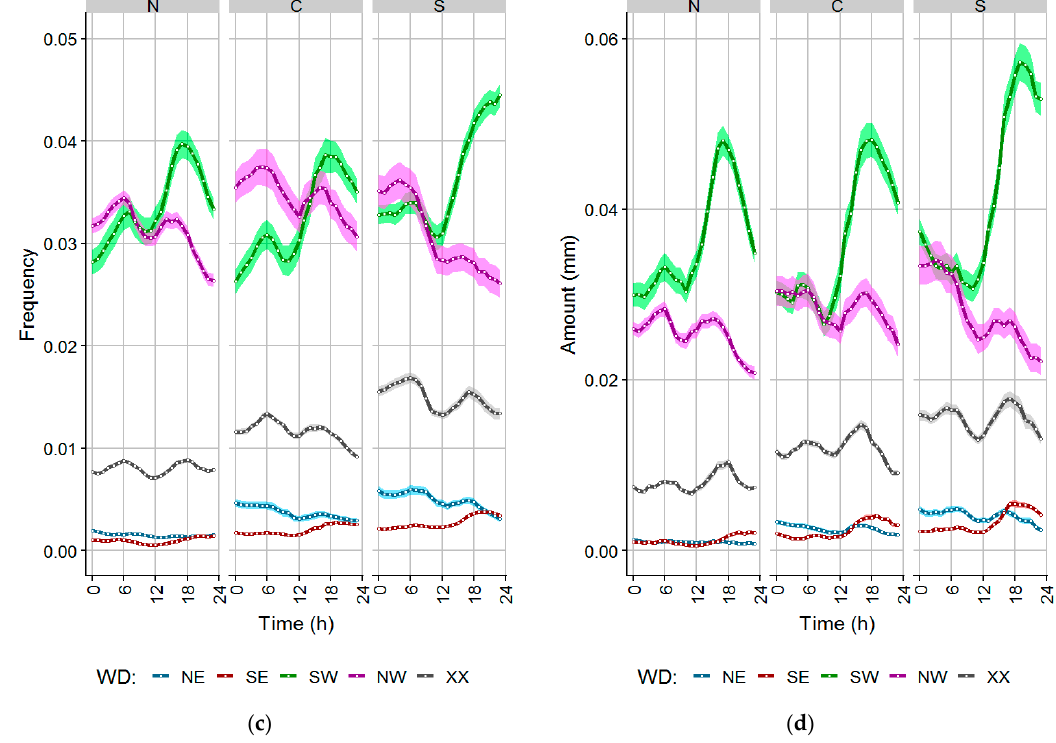
Figure 9. Precipitation diurnal cycle variation in different wind direction (WD) classes and geographical locations represented by the long-term averages of the hourly precipitation occurrence frequency ( a , c ) and the hourly precipitation amount ( b , d ) with the shaded 95% confidence intervals. The colors represent the four WD classes, while the panels represent the station class by latitude ( a , b ) and longitude ( c , d ).